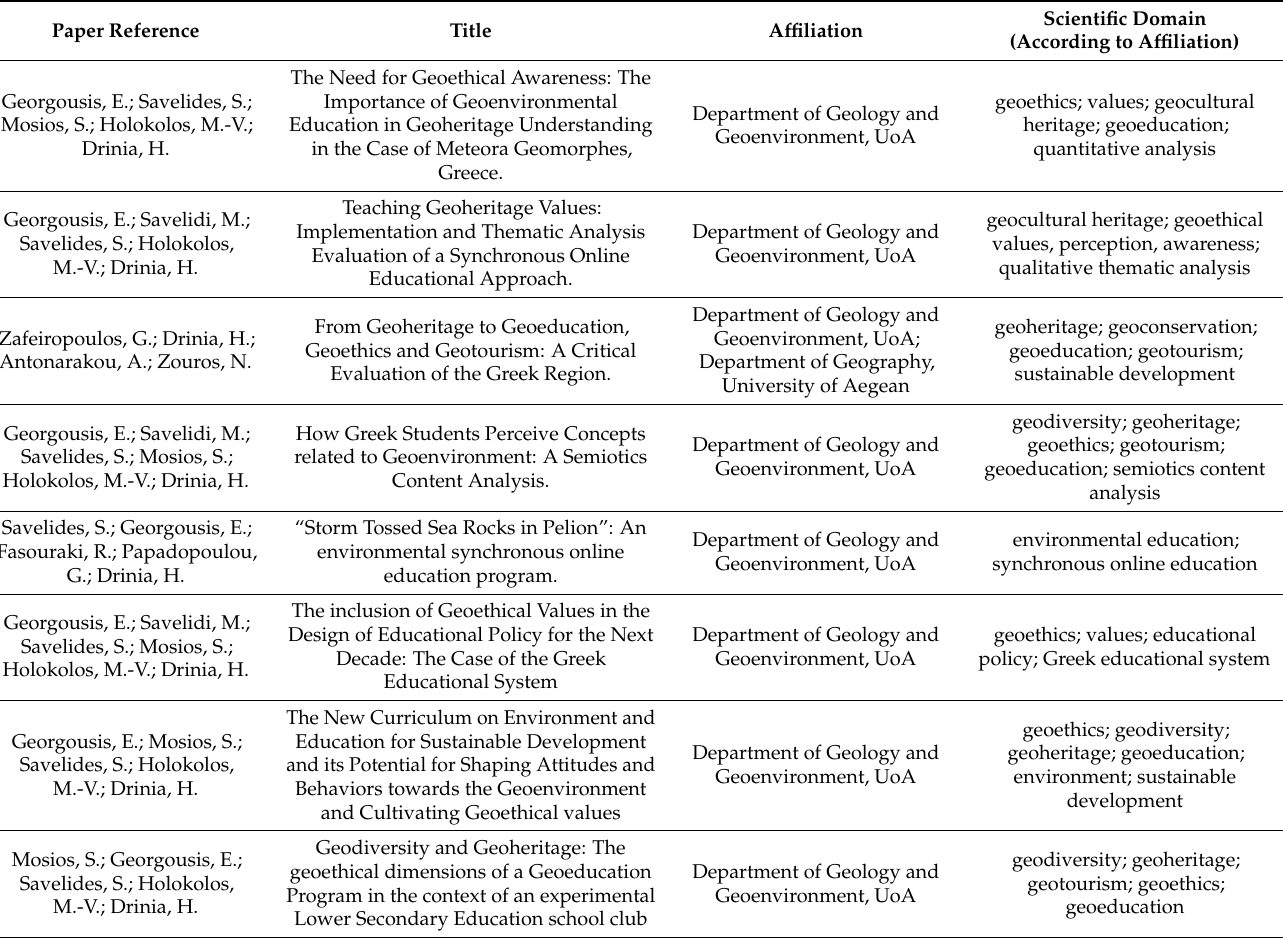
Table 2. Papers and conference presentations on